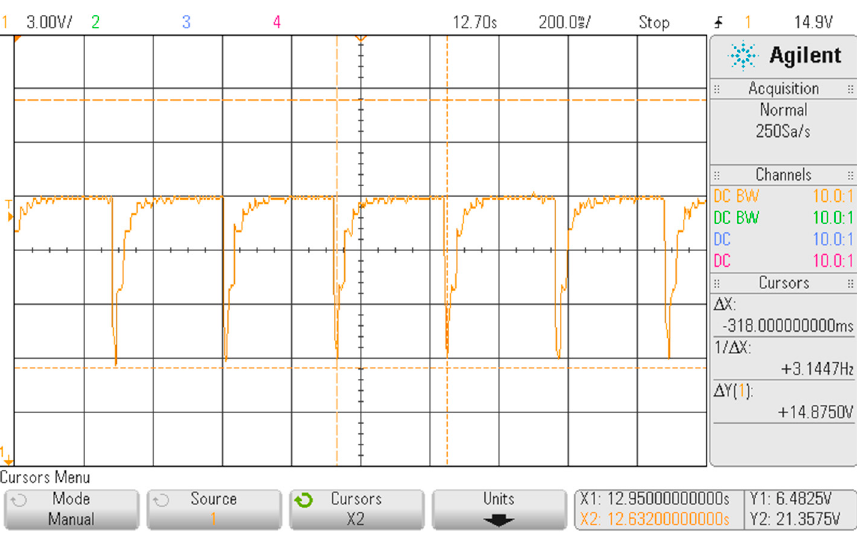
Figure 7. Displayed waveform on the oscilloscope with the FHRS switch in Position “2”.